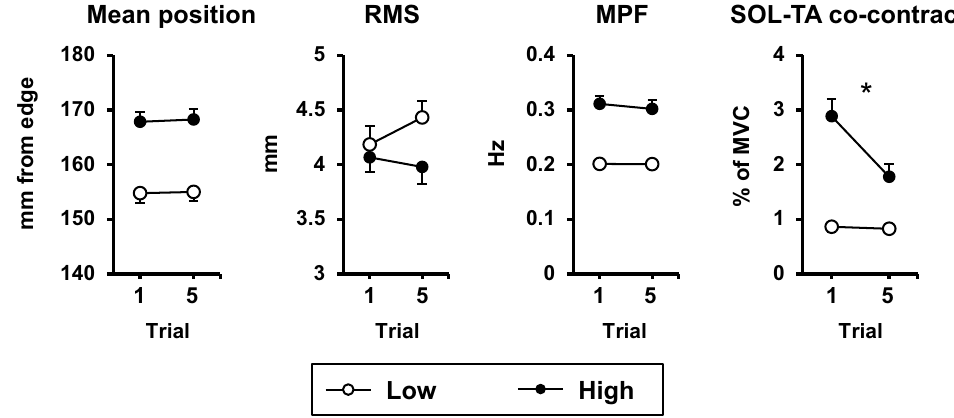
Figure 3. Effect of trial and threat across standing balance measures. Group means and standard errors of standing balance measures for the first and fifth trials across LOW and HIGH threat conditions are shown. RMS = root mean square of centre of pressure; MPF = mean power frequency of centre of pressure; SOL = soleus; TA = tibialis anterior. Asterisks indicate significant threat × trial interactions.